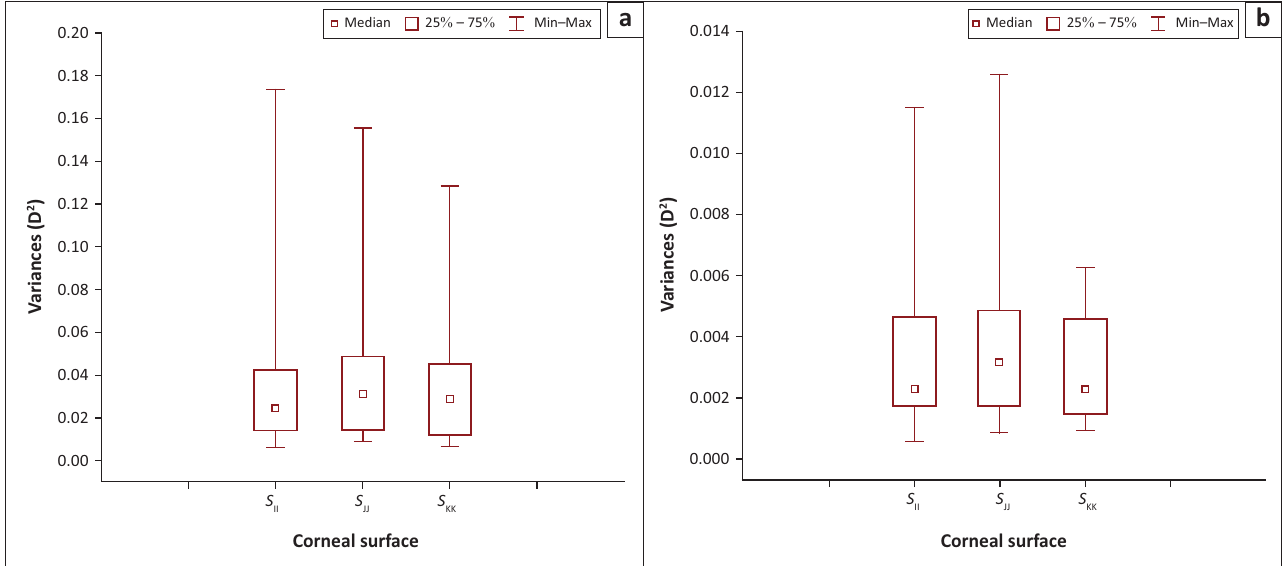
FIGURE 3: Box-and-whisker plots for stigmatic and antistigmatic variances of anterior and posterior central corneal power for 28 eyes with (a) Keratoconus: Anterior corneal surface, (b) Keratoconus: Posterior corneal